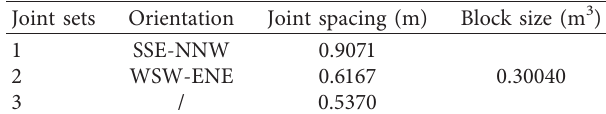
Table 4: Information on joint sets.